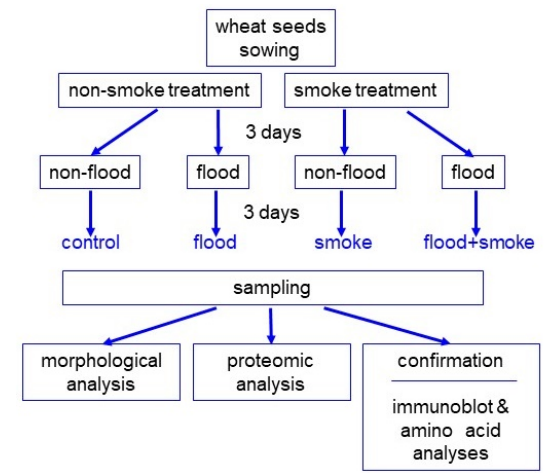
Figure 1. The experimental design for the investigation of the effect of the plant-derived smoke solution on wheat under flooding stress. To investigate the potential effects of the plant-derived smoke solution on wheat, seeds were sown and treated with or without 2000 ppm of the plant-derived smoke solution. After 3 days of sowing, wheat was flooded for 3 days. Wheat seedlings were analyzed with morphological and proteomic methods, and confirmation. For confirmation experiments, immunoblot and amino-acid analyses were used. All experiments were performed with three independent biological replicates.